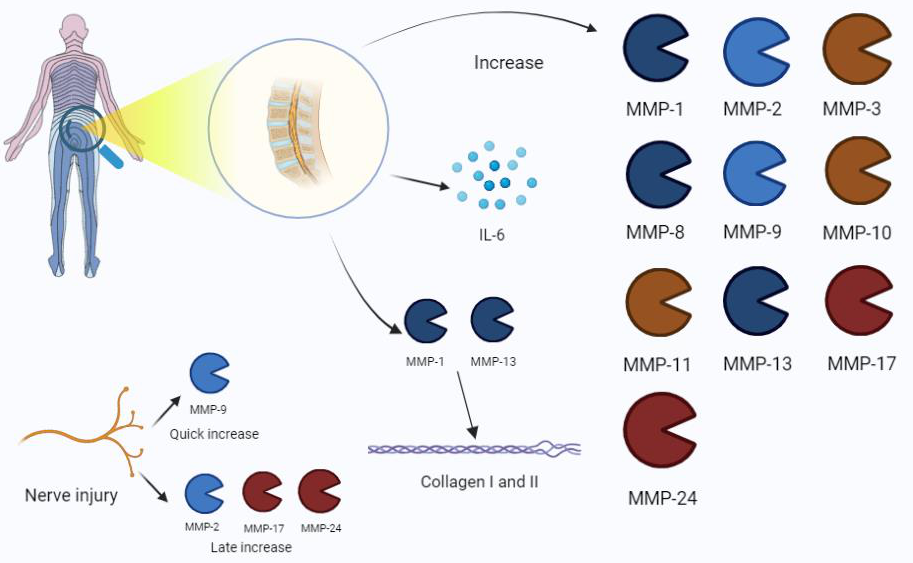
Figure 5. Low-back-pain-associated increase in MMPs. The process is also related to an IL-6 increase in disc pathology. Nerve injury is characterized by the expression of MMP-9 in early phases, and the late increase in MMP-2, -17, and -24. Among MMPs, MMP-1 and -13 are mainly involved in collagen disruption in intervertebral disc damage. IL, interleukin .